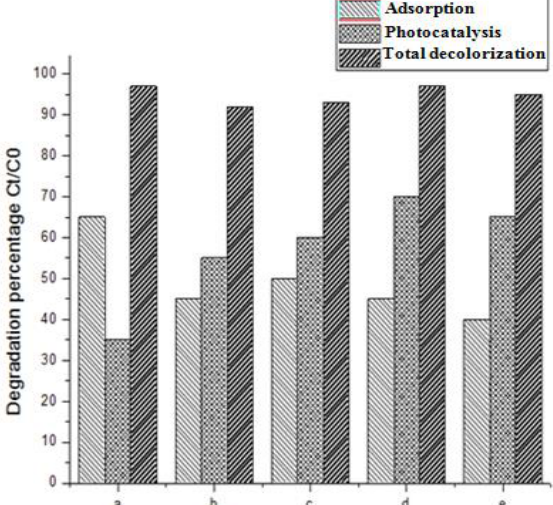
Fig.7. Decolorization rate of (a) n-CeO